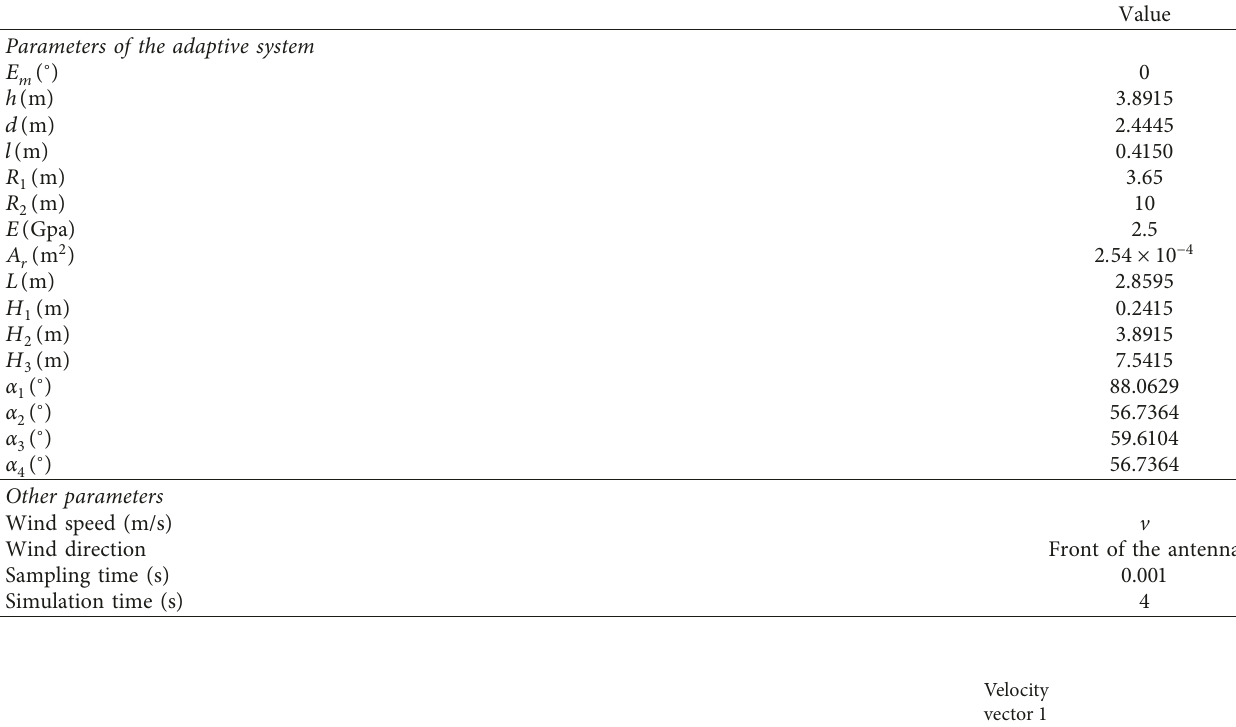
Table 1: Parameters used for simulation.